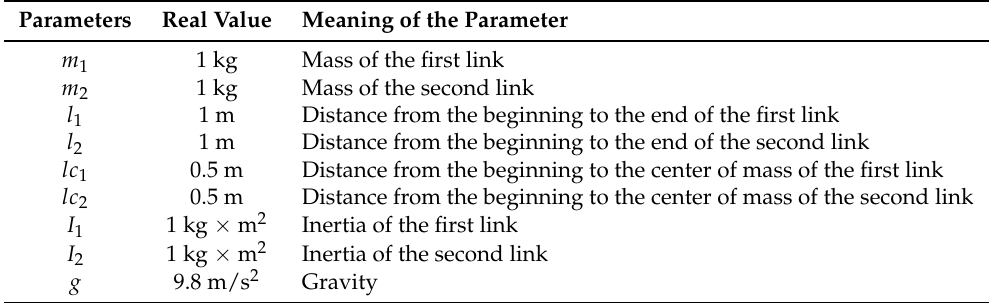
Table 1. Parameters of the